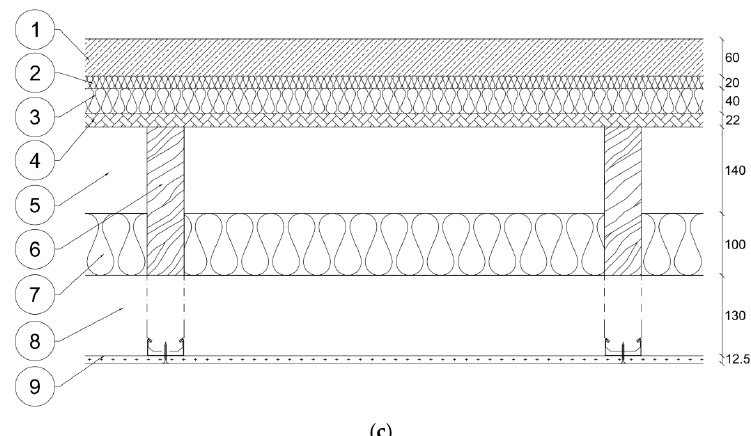
Figure 3. Cross-section of a wooden frame floor: ( a ) Model 3a; ( b ) Model 3b; ( c ) Model 3c. (1—self-levelling screed, 2—mineral wool ρ = 150 kg/m 3 , 3—mineral wool ρ = 107 kg/m 3 , 4—OSB board, 5—air gap, 6—wooden joists, 7—mineral wool ρ = 12 kg/m 3 , 8—air gap, 9—plaster board).